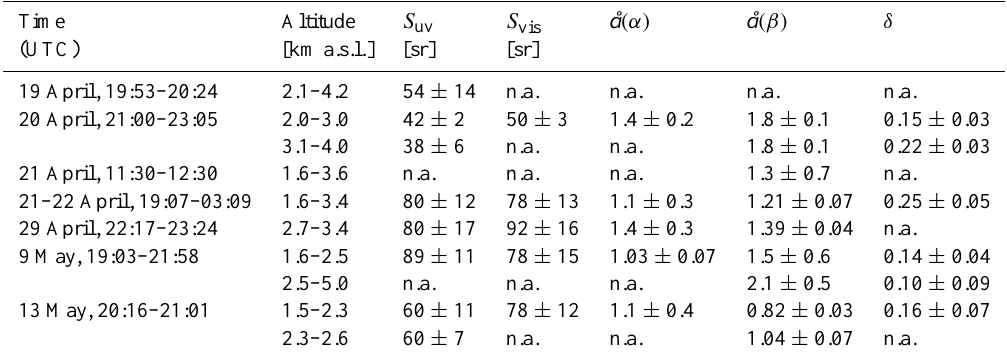
Table 1. Intensive properties calculated within identified volcanic layers. Mean values and standard deviations of the lidar ratio at 355nm ( S uv ) and 532nm ( S vis ) ; ˚Angstr¨om exponent at 355/532nm ( ˚a (α) ); backscatter-related ˚Angstr¨om exponent at 532/1064nm ( ˚a (β) ) and particle linear depolarization ratio at 532nm (δ) are